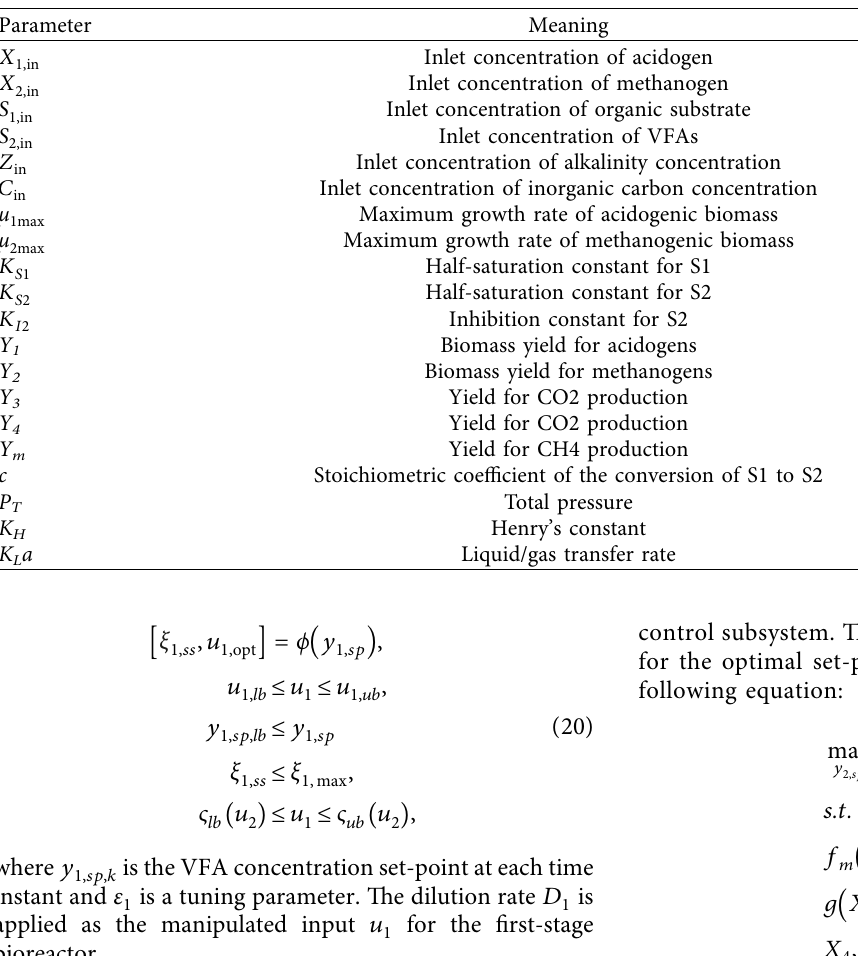
Table 1: Parameter values for the two-stage anaerobic digestion